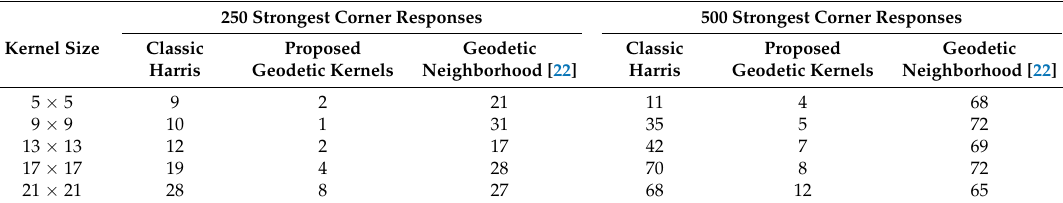
Table 2. False corner detection of the proposed geodetic kernel definition, the geodetic neighborhood definition in [22] and classic Harris-based corner detection. The number of wrongly detected corners by each method, considering the 250 and 500 strongest responses are shown.